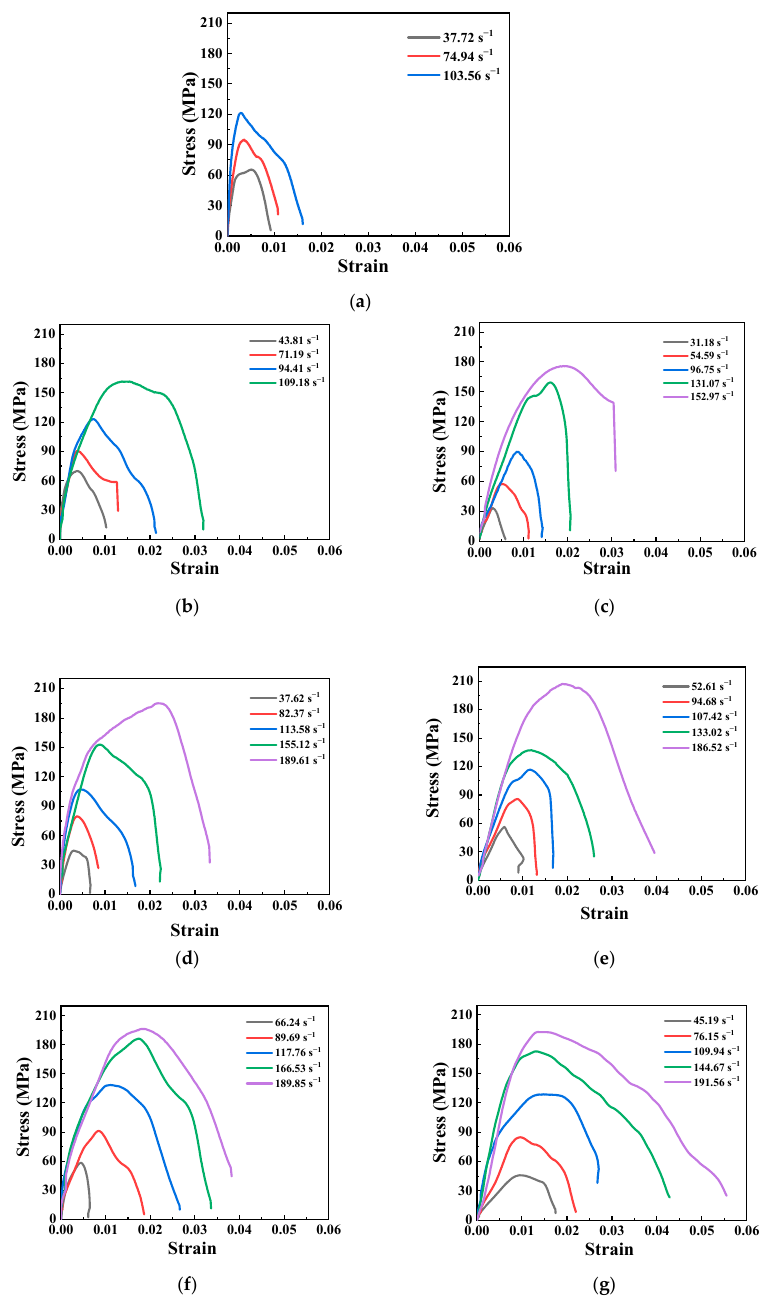
Figure 4. Impact compression stress–strain curves of UHPC: ( a ) U-SF0; ( b ) U-SF2; ( c ) D-SF2; ( d ) U-SF4; ( e ) D-SF4; ( f ) U-SF6; and ( g ) D-SF6.